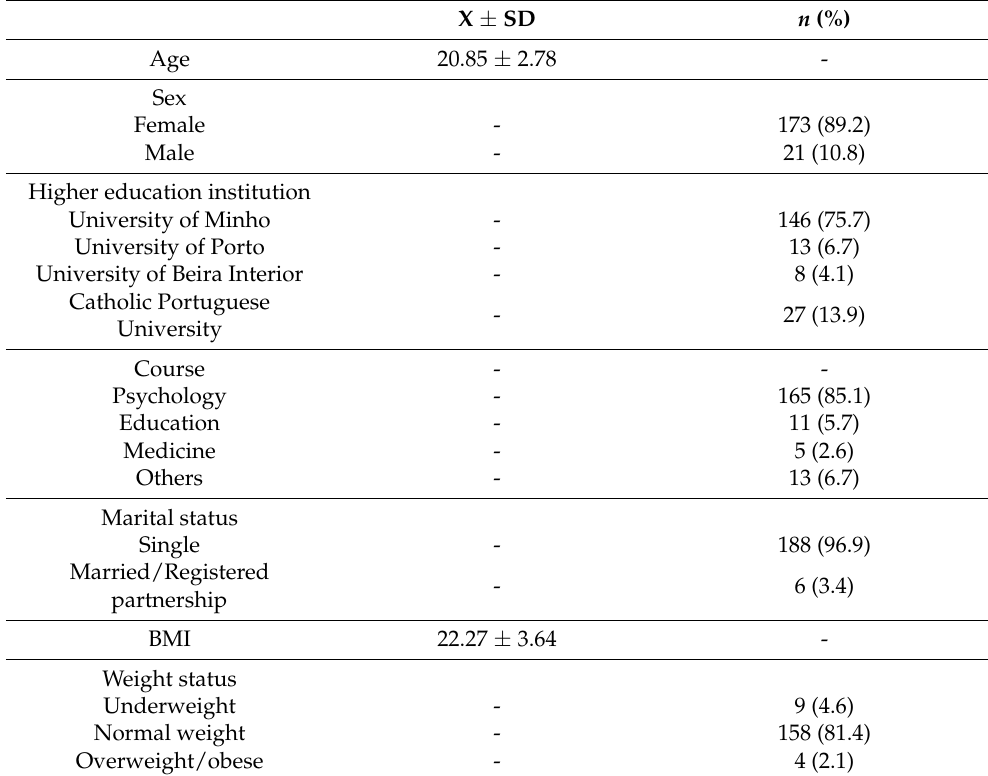
Table 1. Socio-demographic and anthropometric characterization of the study